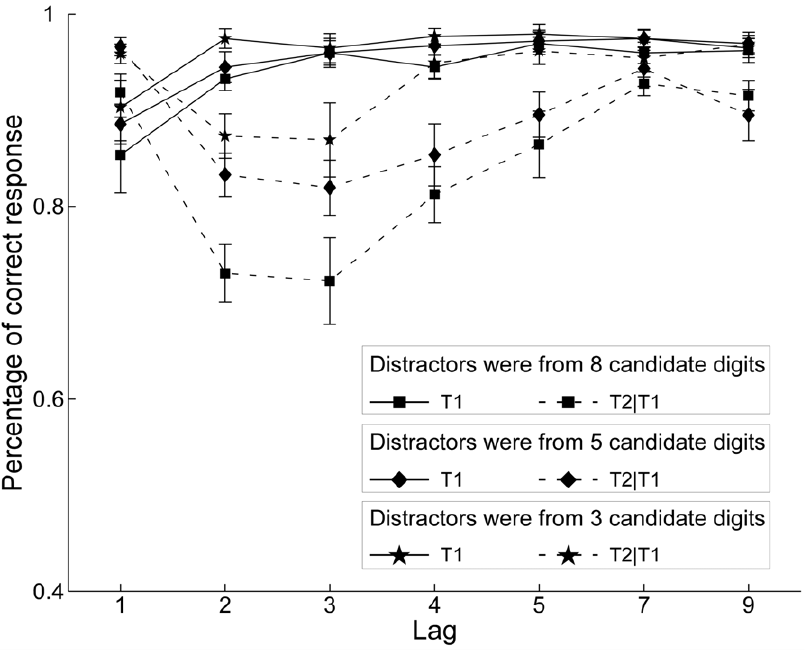
Figure 3. Percentage of correct responses in Experiment 2. Mean percentage correct report of T1 (solid lines) and T2 when T1 was correct (dotted lines) as a function of SOA in the three candidate digits experimental condition (star symbols), the five candidate digits experimental condition (diamond symbols), and the control condition (square symbols) of Experiment 2.